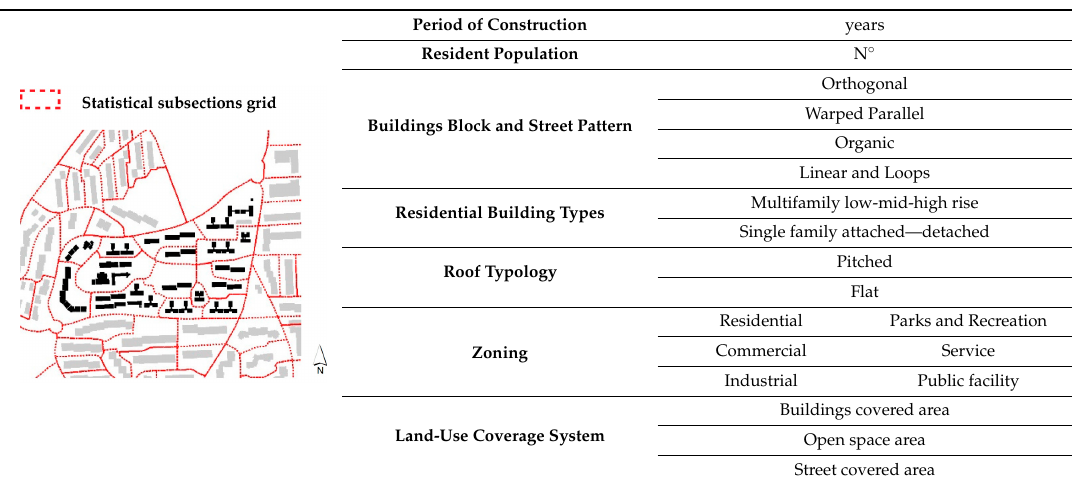
Table 2. Delimitation criteria of the urban unit.